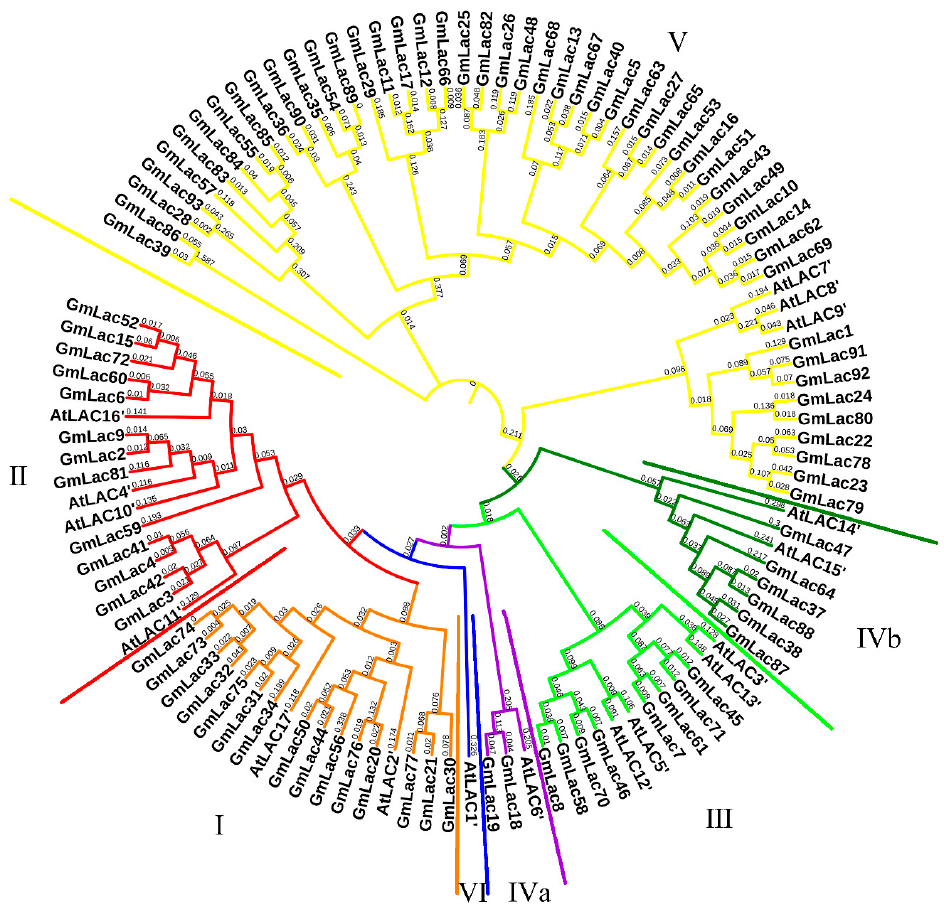
Figure 2. The phylogenetic tree of the Arabidopsis and soybean laccase proteins. In total, 93 soybean and 17 Arabidopsis laccase proteins were aligned using the ClustalW program. The neighbor-joining tree was constructed using MEGA7.0. The bootstrap value was set as 1000 replicates. The length of each branch is shown next to the branches.